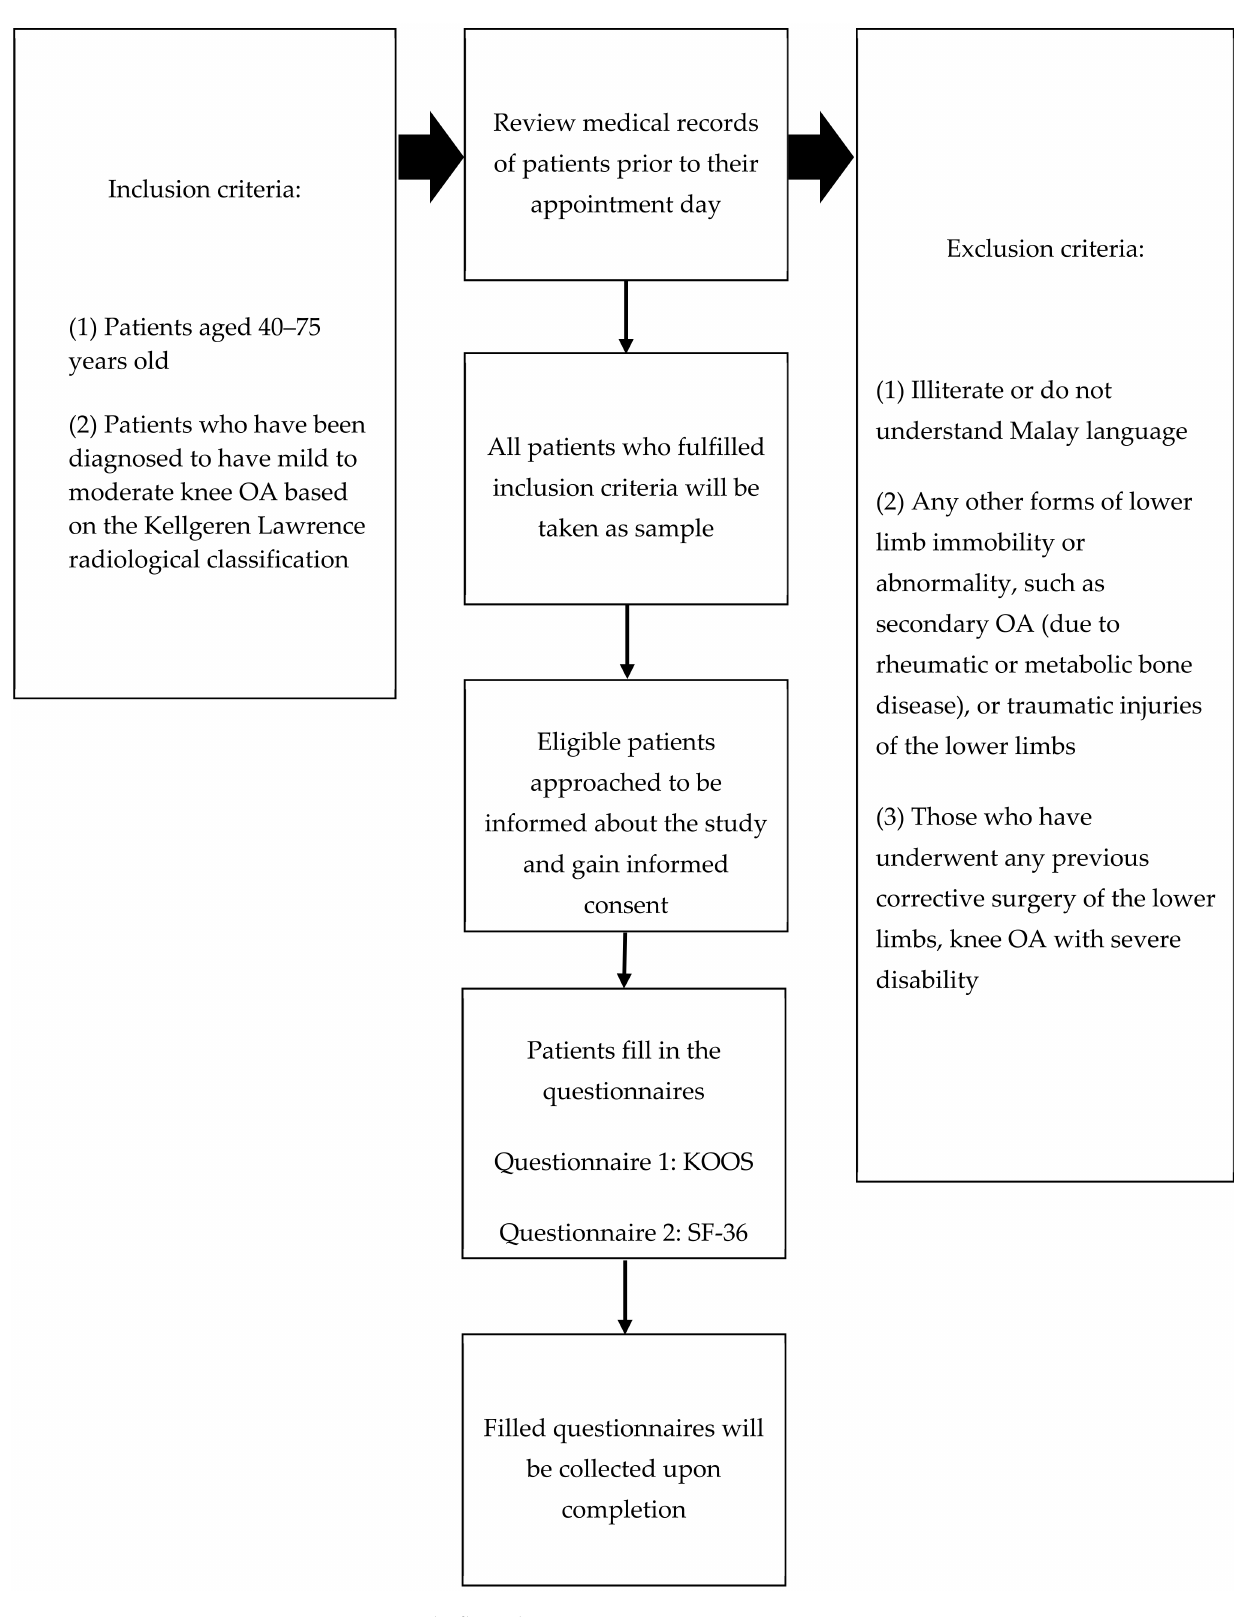
Figure 1. Study flow